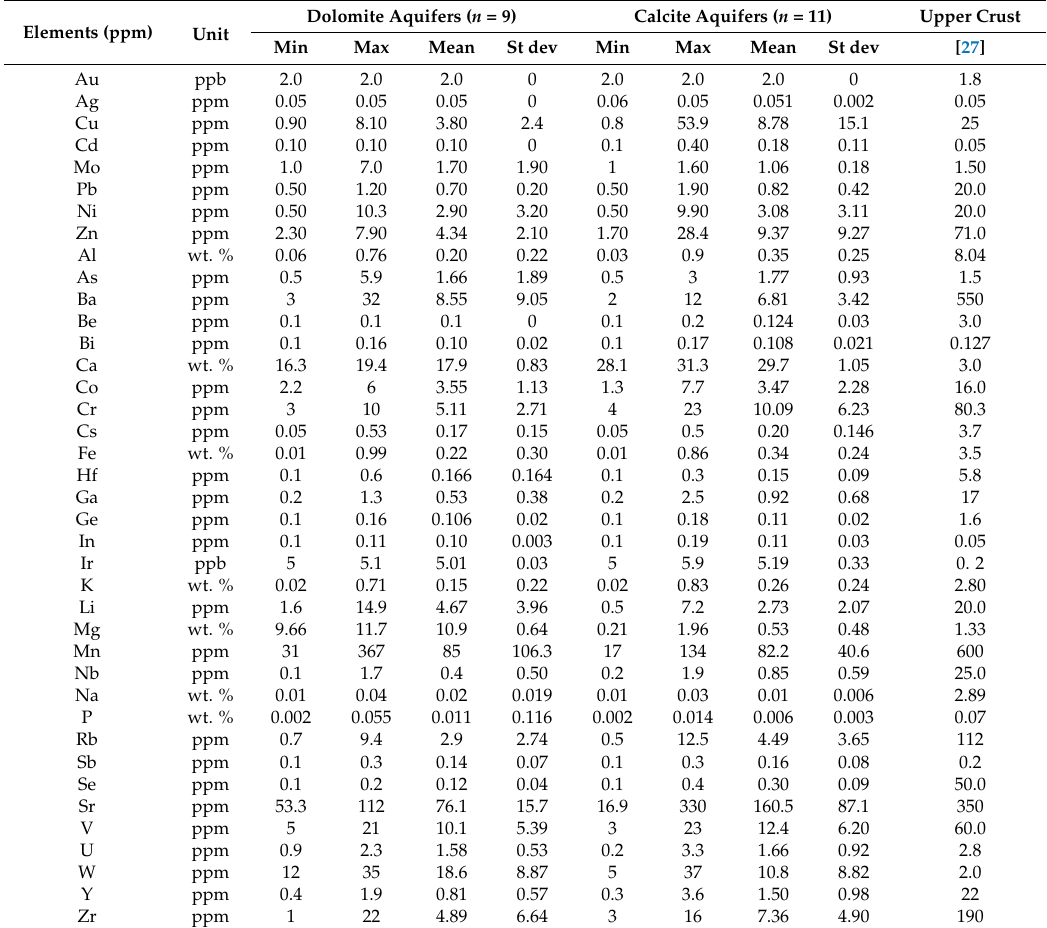
Table 2. Trace elements analyses of rock